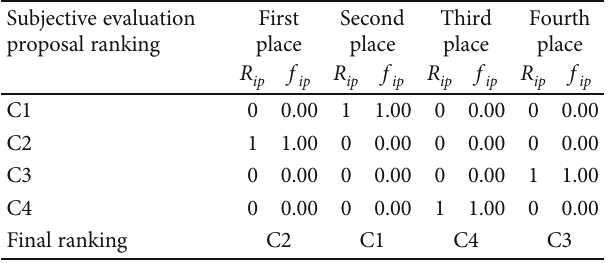
Table 5: Frequency table of subjective evaluation.